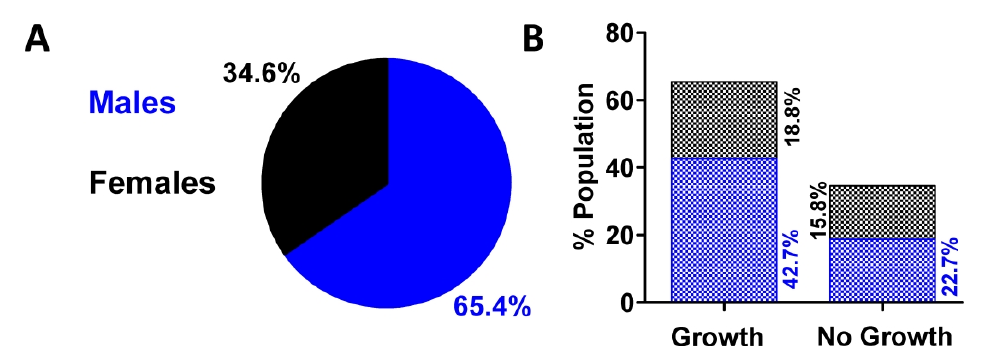
FIGURE S1 - Frequency of culture growth and susceptibility patterns of various antibiotics against Gram-positive and Gram- negative Bacteria. TABLE I - G ender wise prevalence of bacterial isolates